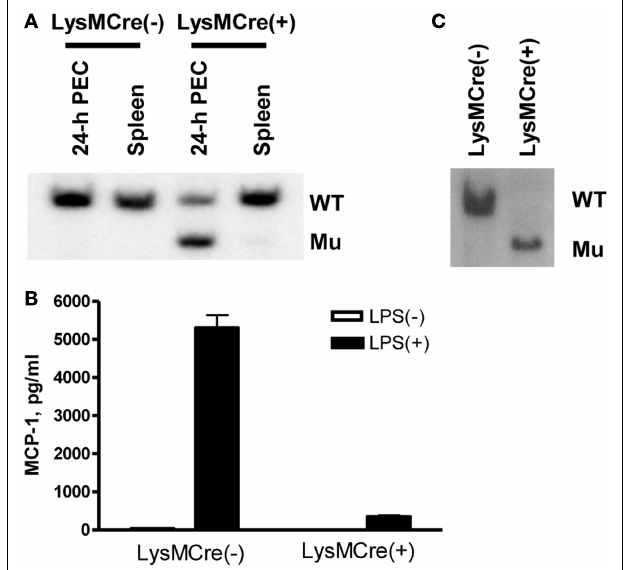
FIGURE 1 | Generation of myeloid cell-specific MCP-1-deficient mice . (A) Genomic DNA was isolated from 4-dayTG-induced PEC or spleen of LysMCre − , MCP-1 flox/flox or LysMCre + , MCP-1 flox/flox mice.The DNA were digested with Pst I and subjected to Southern blotting for the presence of WT or mutant (Mu) allele. (B) 1.8 × 10 6 PEC from LysMCre − , MCP-1 flox/flox or LysMCre + , MCP-1 flox/flox mice were cultured in 1ml medium for 24h in the absence or presence of 100ng/ml LPS.The concentration of MCP-1 in the culture supernatants was measured by ELISA. Data is presented as the mean ± SD obtained with cells from three mice. (C) PEC isolated 4 days afterTG injection were incubated in tissue culture plates at 37°C overnight, non-adherent cells were removed, and then adherent cells were lysed to obtain genomic DNA.The DNA were digested with PstI and then subjected to Southern blotting for the presence ofWT or mutant (Mu)